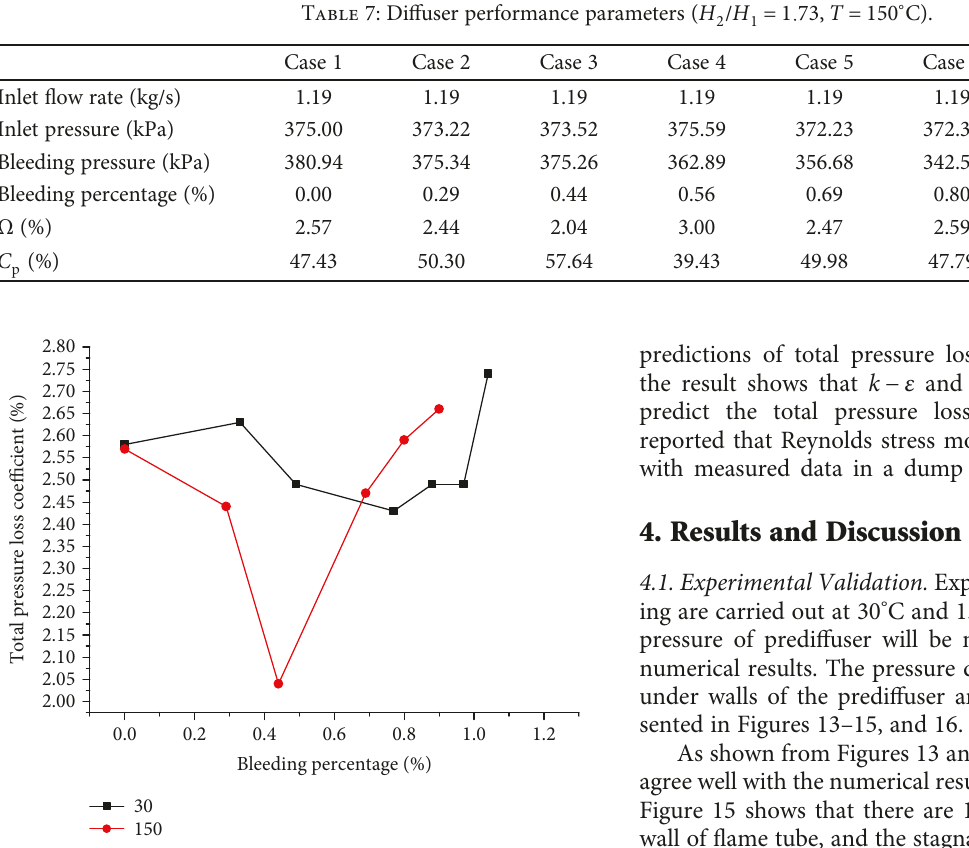
Figure 17: Relationship between the total pressure loss coe ffi cient and the bleeding percentage (1.73 expansion